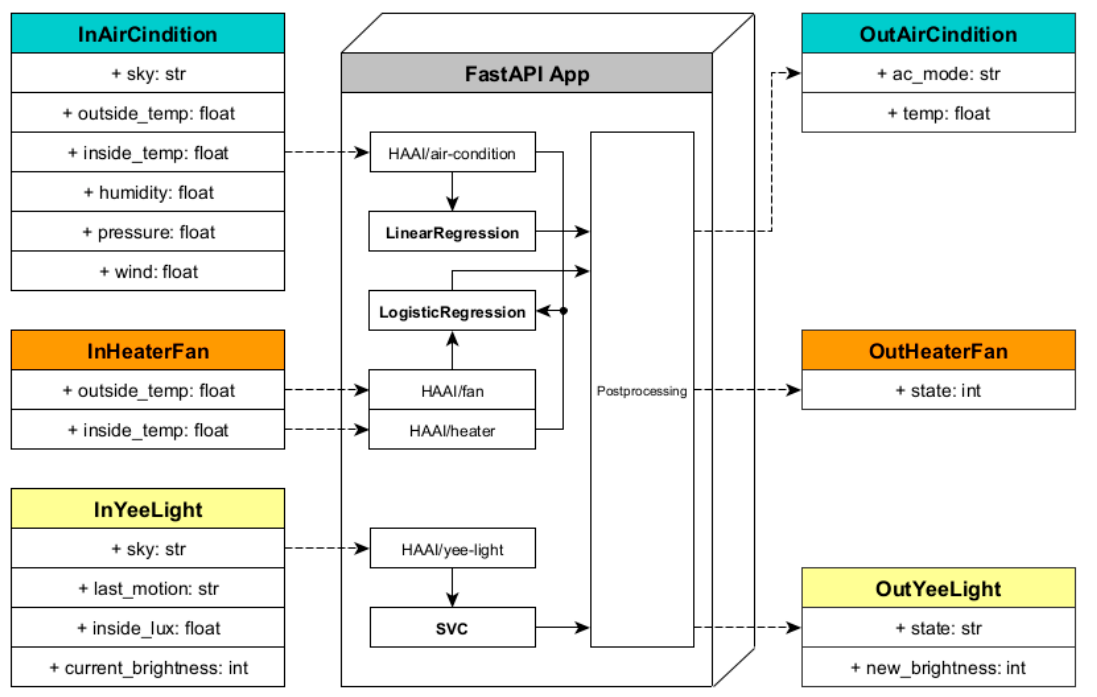
Figure 19. Scheme/algorithm of ML activities of the building used designed by CBRTI Sp. z o.o. Research and Develop- ment Center.